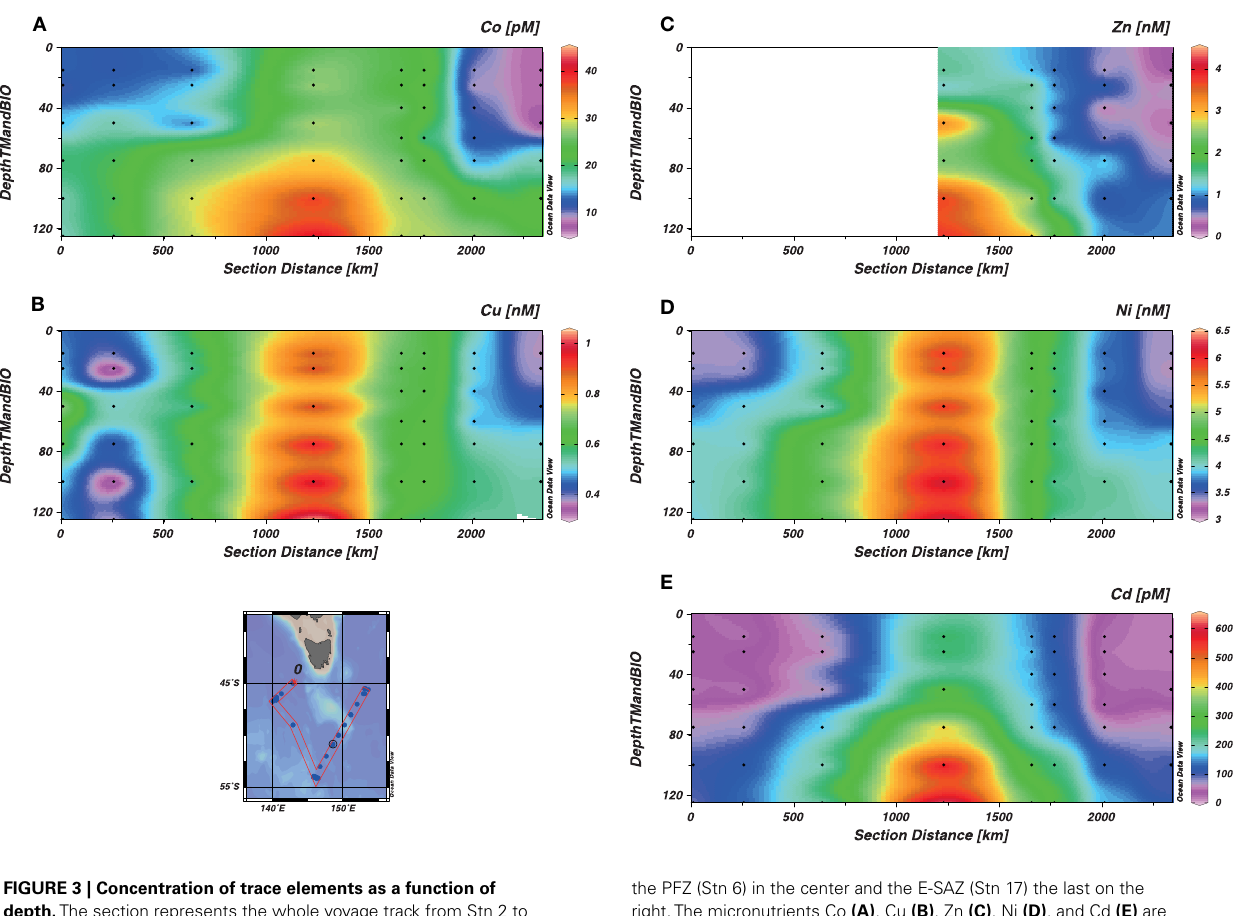
the PFZ (Stn 6) in the center and the E-SAZ (Stn 17) the last on the right.The micronutrients Co (A) , Cu (B) , Zn (C) , Ni (D) , and Cd (E) are